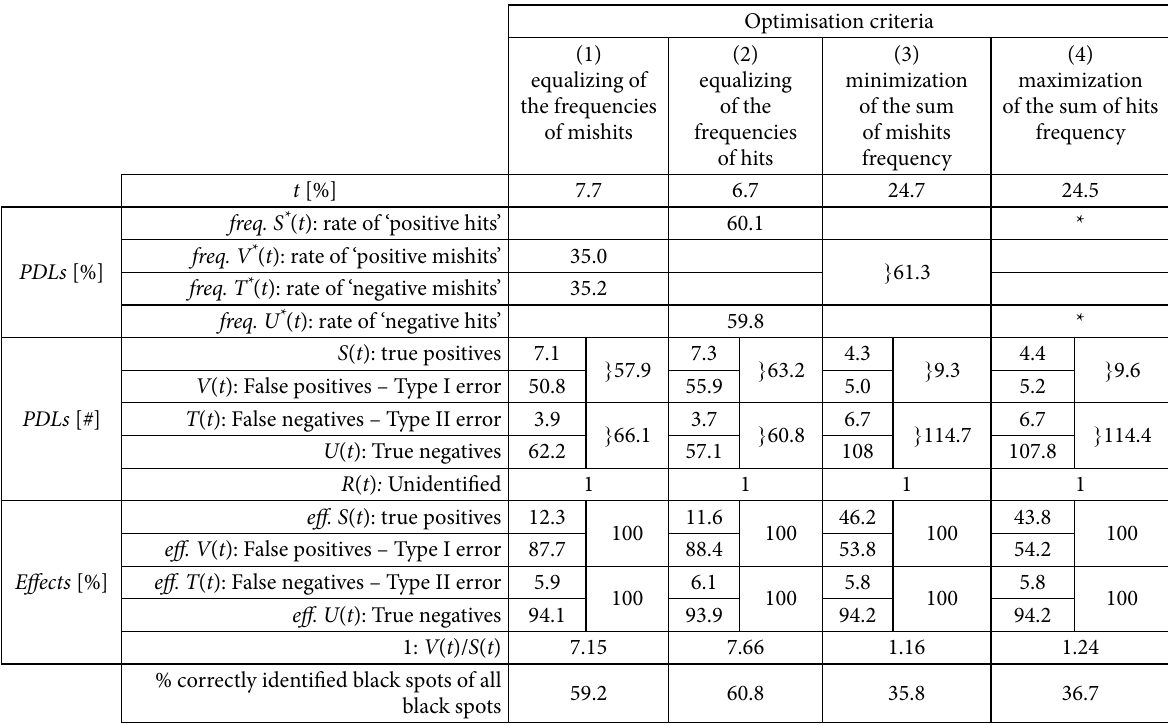
Table 4. The overview of optimisation